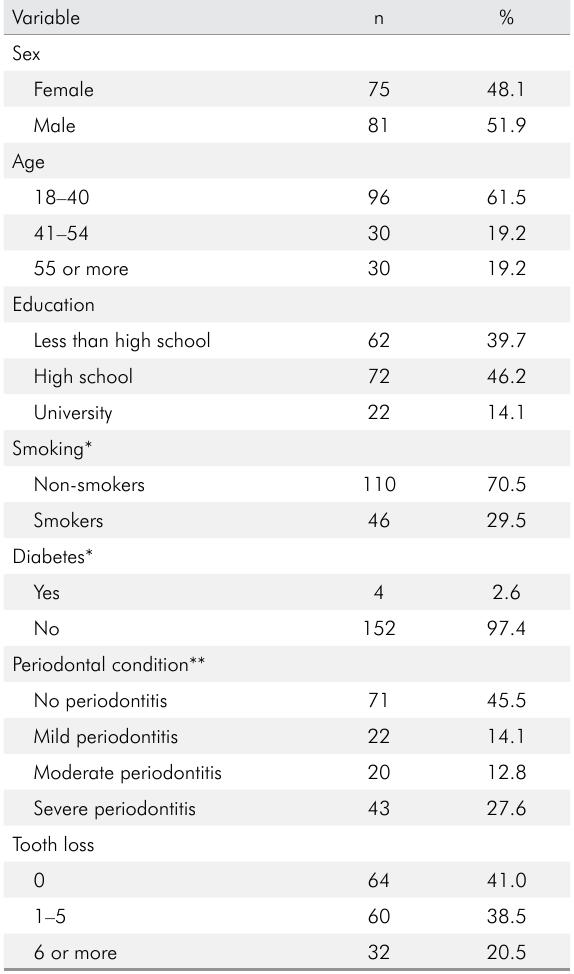
Table 1. Study population characteristics (n =